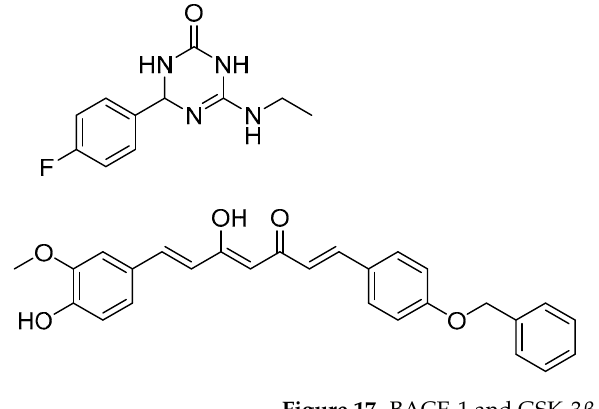
Figure 17. BACE-1 and GSK-3 β inhibitors.